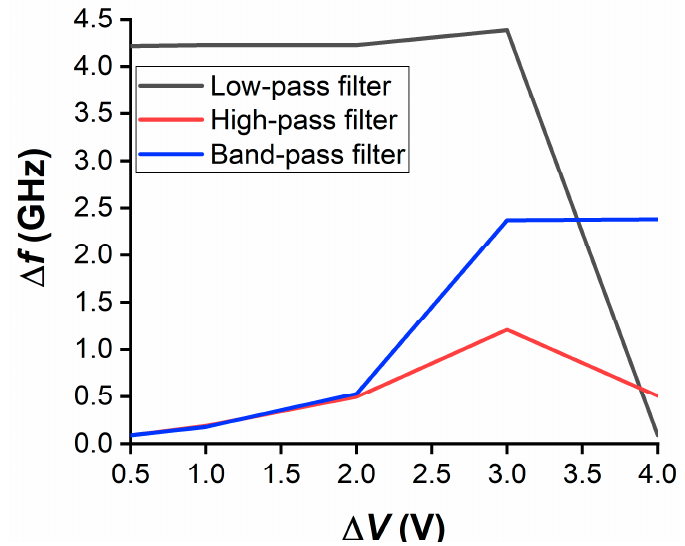
Figure 6. Frequency shift of the reflection coefficient |S 11 | for the three filters in the reference band, as a function of the applied DC bias voltage.